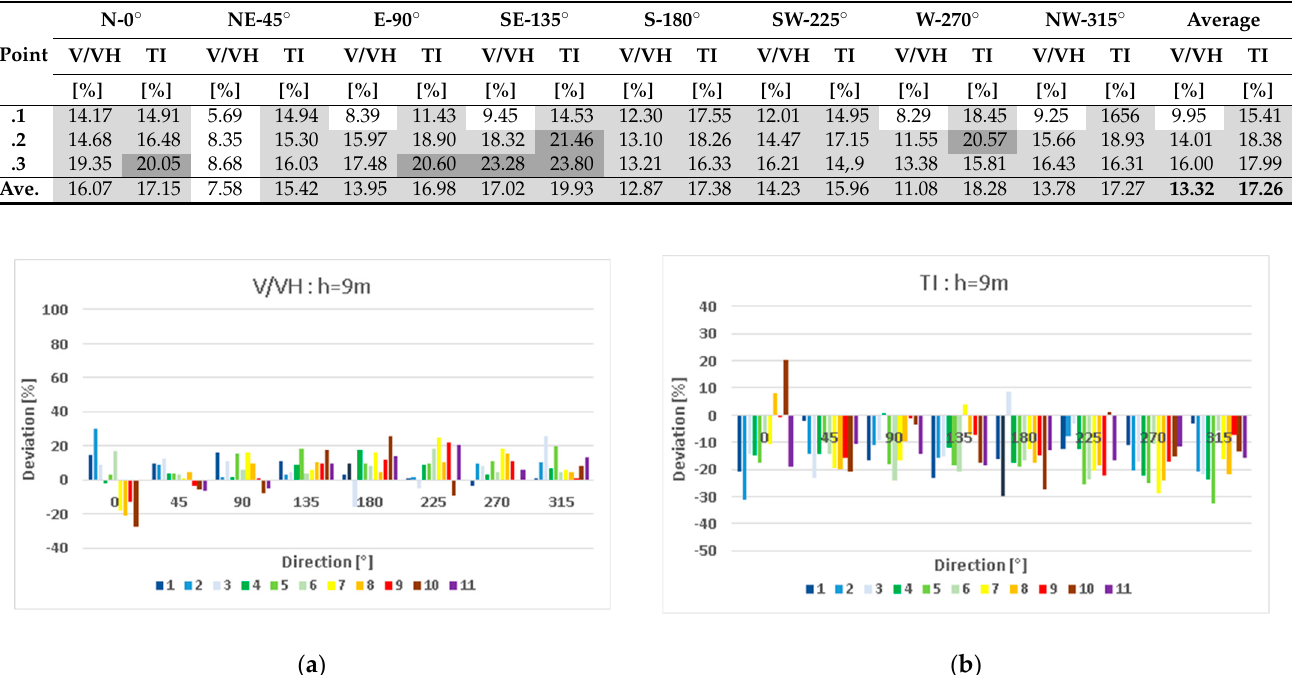
Figure 25. Mean absolute deviations of the wind ( a ) and turbulence intensity ( b ) per direction for the 11 probe validation points at height h = 9 m with OpenFOAM.